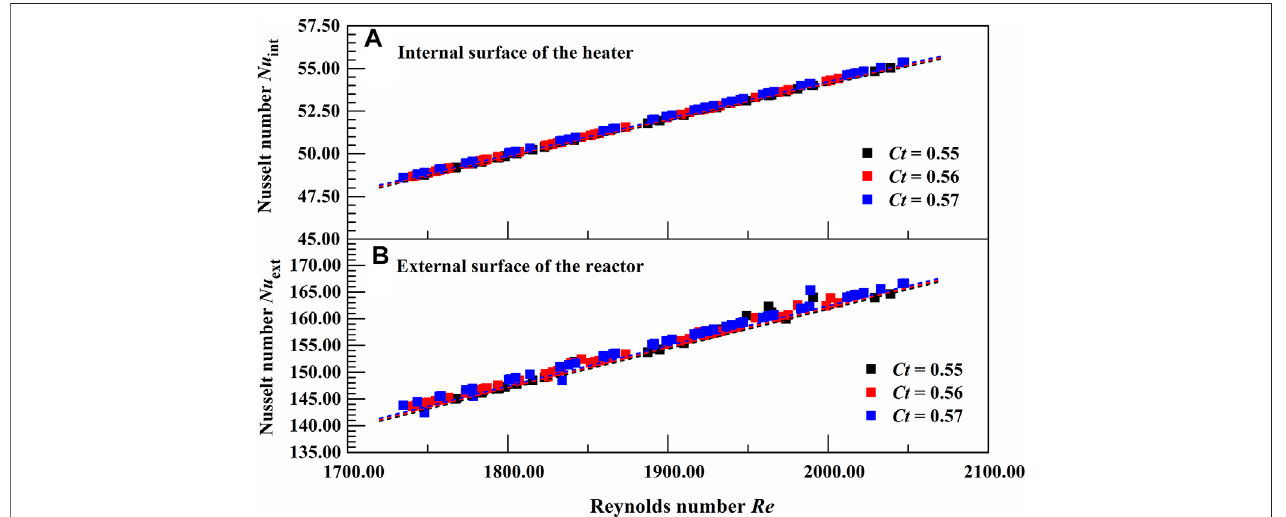
FIGURE 4 | Relationship between Nusselt number and relative dimensionless parameters of the forced convection.